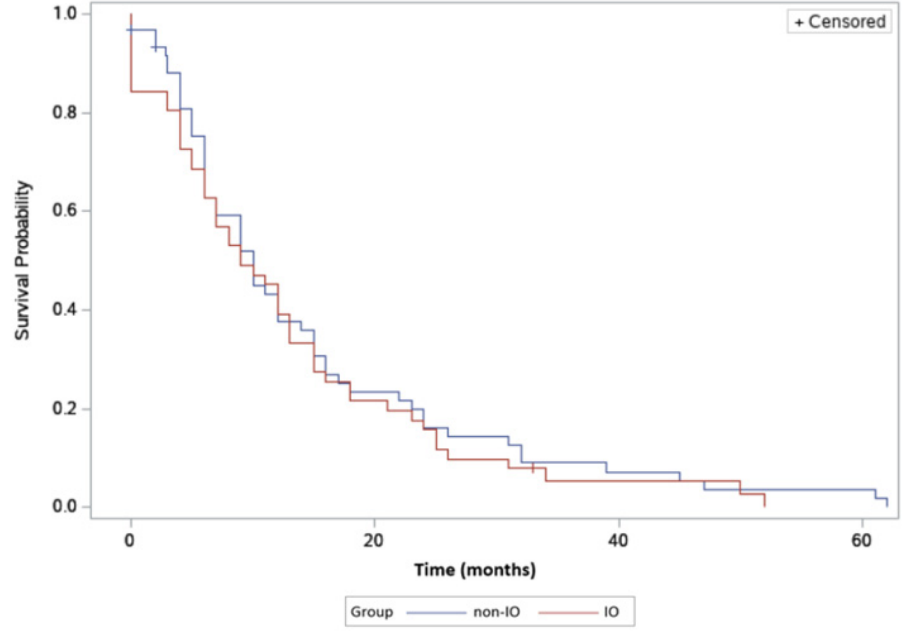
Figure 4. Overall survival in HCV-positive HCC patients in IO versus non-IO subgroups. The blue line represents the non-IO whereas the red line represents the IO population.